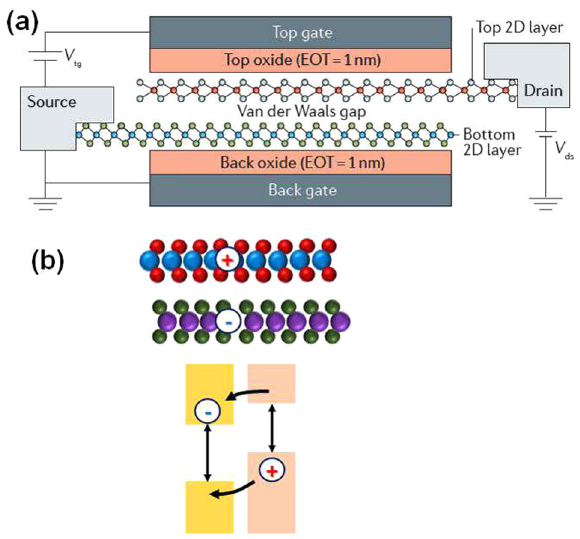
Fig. 22 Generic Structure of 2D vdW-TFETs. a Schematic repre- sentation of typical vdW-TFET, adapted with permission from 1